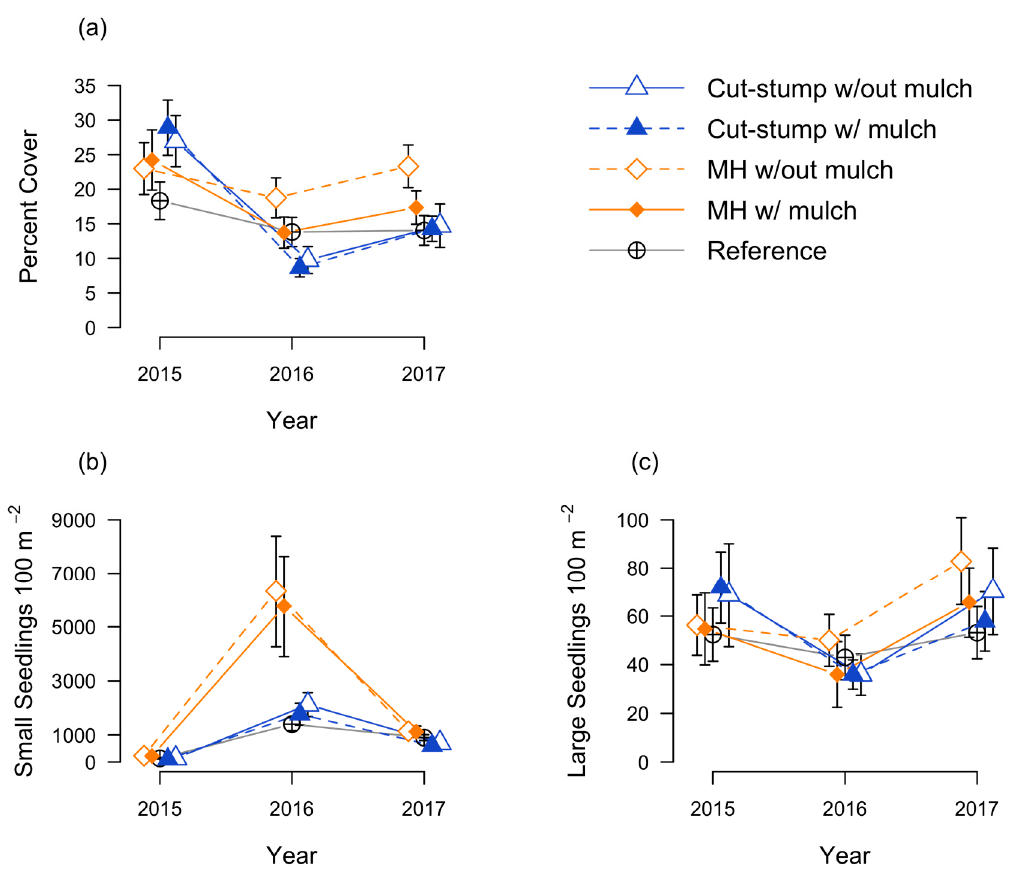
Figure 3. Honeysuckle responses to removal treatments conducted in November and December 2015, including percent cover below 1 m ( a ), density of honeysuckle seedlings <0.5 m tall ( b ), and density of honeysuckle seedlings 0.5–1.37 m tall ( c ). Honeysuckle removal was accomplished using cut-stump or forestry mulching head (“MH”) treatments, with mulch removed/absent or added/present. Honeysuckle were not removed in reference areas for comparison. Dashed lines indicate management techniques with mulch manipulated (added/removed) and solid lines represent operational (no mulch manipulation) management techniques. Values are means ± standard error. Data were collected from mid-July to late August at four mature secondary hardwood forest sites near West Lafayette, IN, USA.